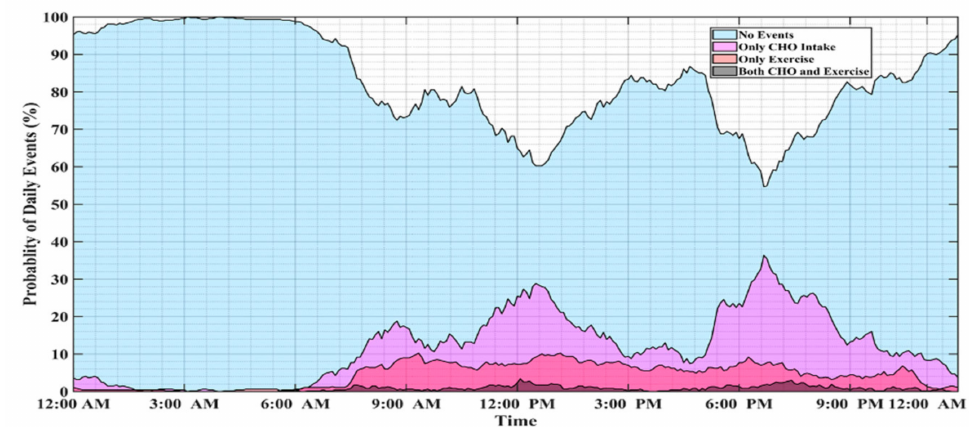
Figure 4. The probability of meal and physical activity events during a day was obtained by analyzing 15 months of the pump-CGM sensor, meal, and physical activity data of a random person with T1D from the Tidepool dataset